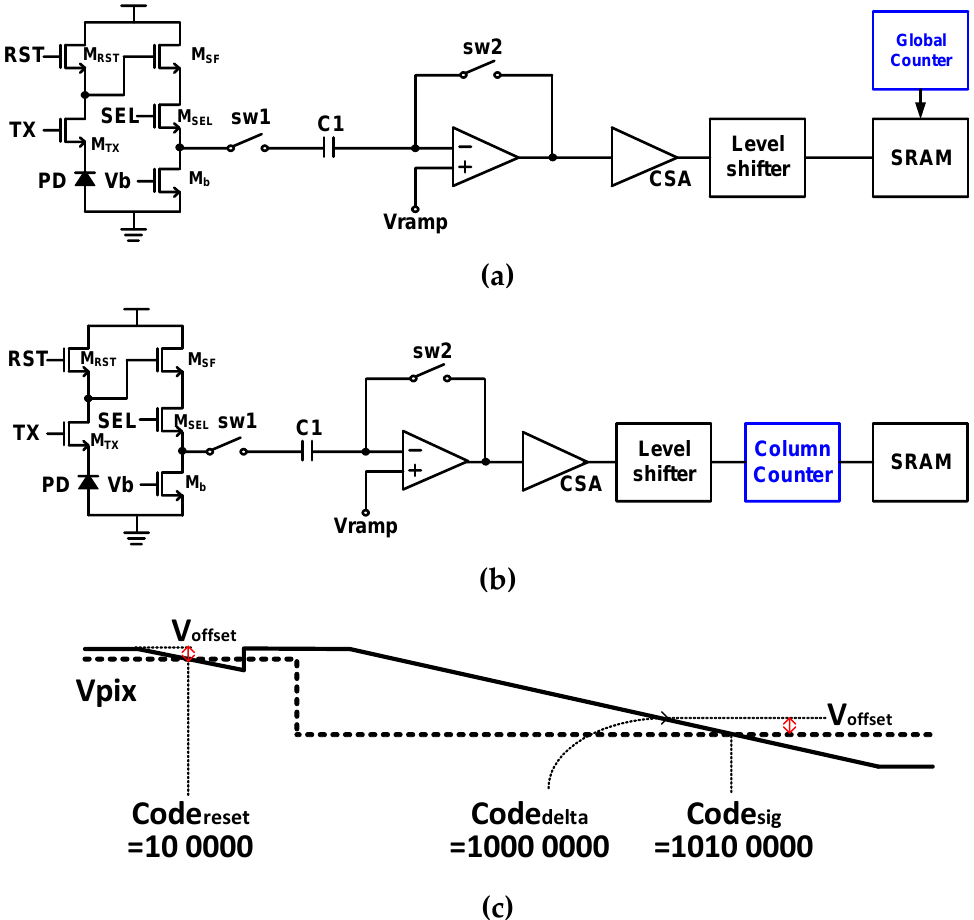
Figure 3. The block diagrams of ( a ) A-CDS and ( b ) D-CDS, and ( c ) Operation of D-CDS.